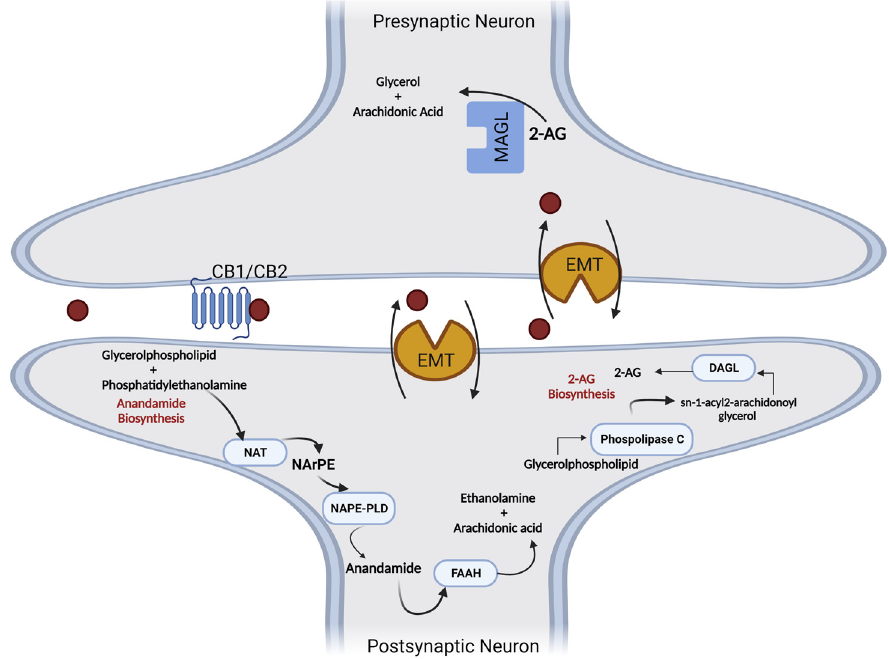
Figure 5. Metabolic pathways involved in the synthesis and degradation of anandamide (5) and